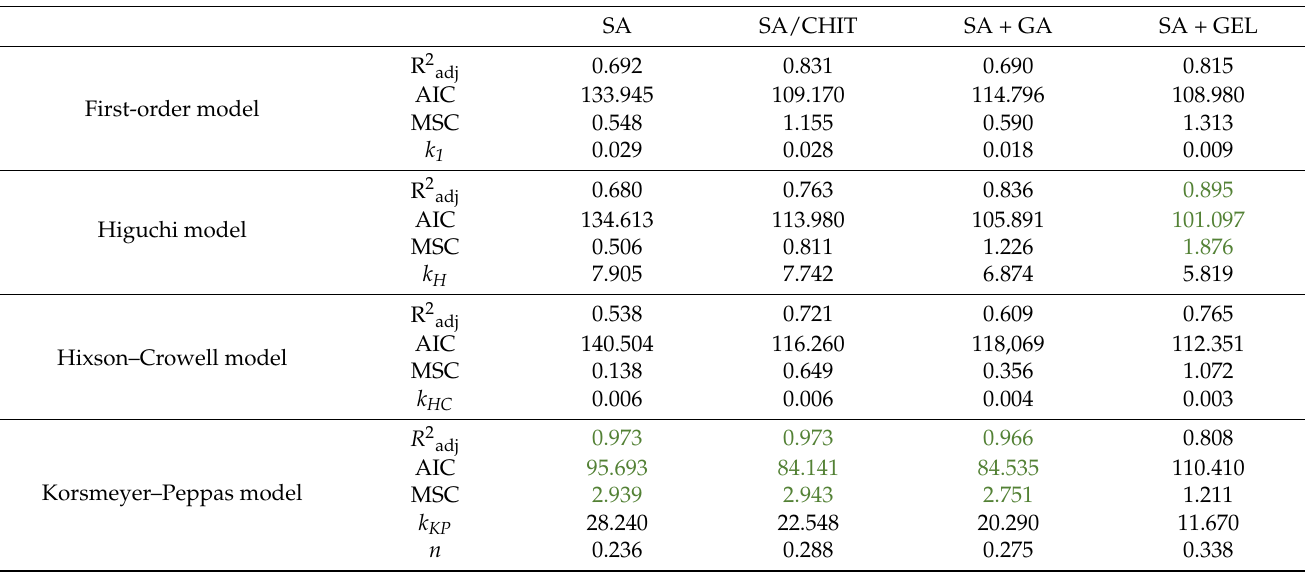
Table 7. Estimated parameters of the applied mathematical models for describing the release kinetics of phenolic compounds ( k 1 , k H , k HC , k KP —release constants for the corresponding model; n —the diffusional exponent) from freeze-dried microbeads containing grape pomace extract prepared with different coatings, and statistical criteria for the success of the model approximation (R 2 adj—the adjusted coefficient of determination, AIC—the Akaike information criterion, MSC—the model selection